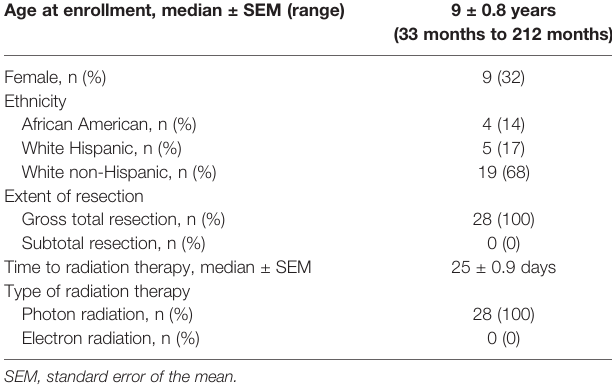
TABLE 1 | Patient characteristics.